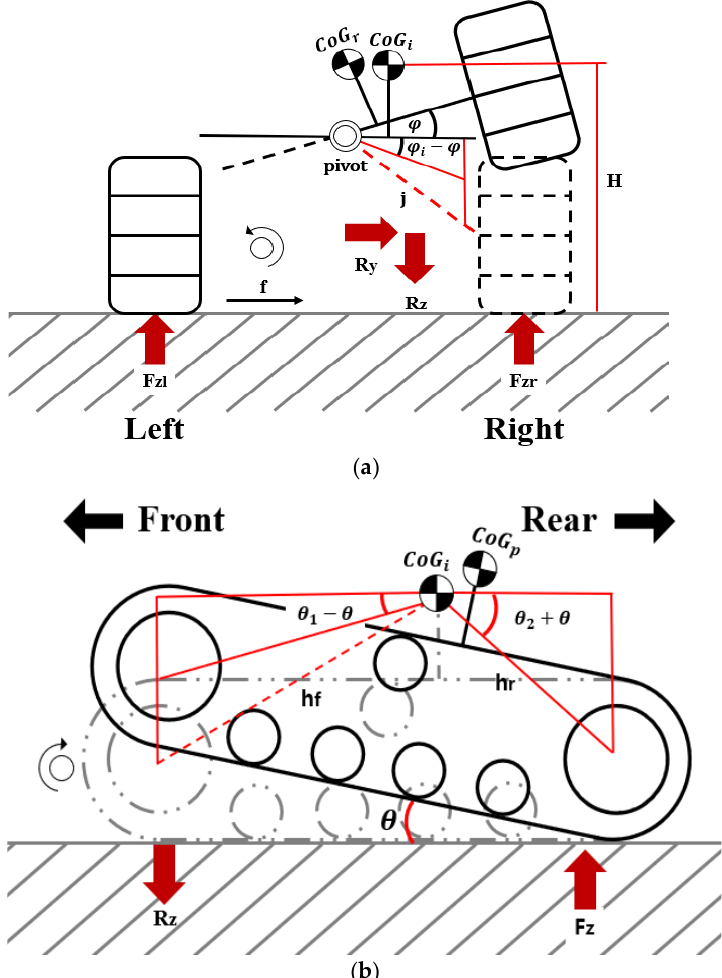
Figure 1. Force diagram of each motion ( a ) roll ( b ) pitch.